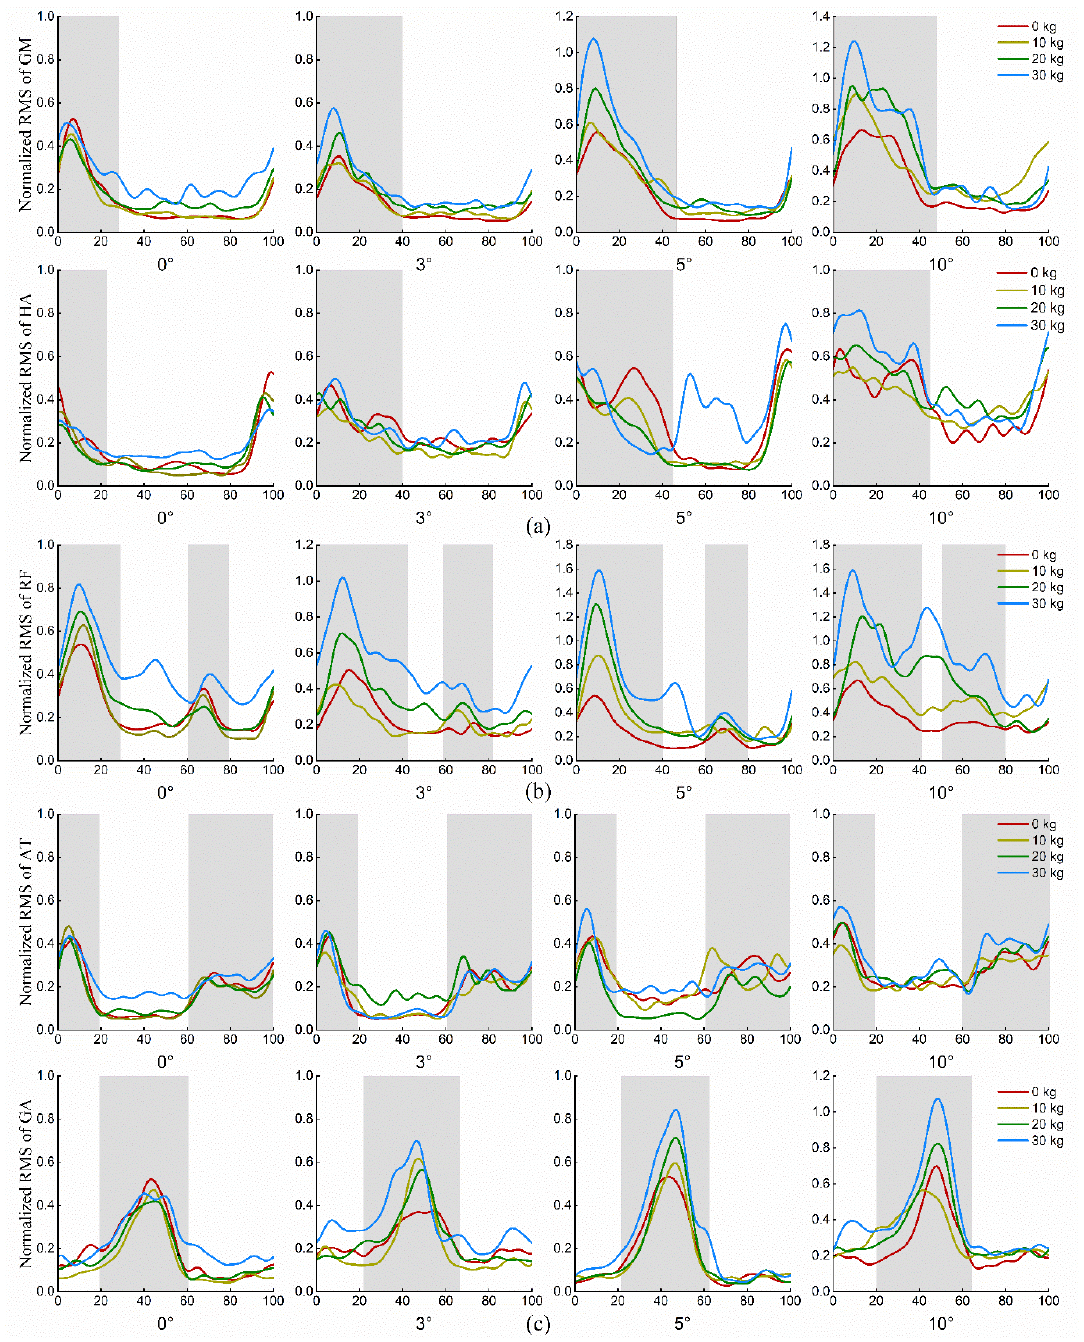
Figure 3. The muscle activity of leg muscles in one gait during di ff erent slope walking across all backpack loads, normalized to the mean activity during level walking without backpack loads: ( a ) The muscle activity of the hip extensor muscles. ( b ) The muscle activity of the knee extensor muscles. ( c ) The muscle activity of the ankle muscles. The di ff erent colors of the curves had the same representation as those colors in Figure 2. The gray area represented the higher muscle activation duration in one gait. RMS: root mean square.